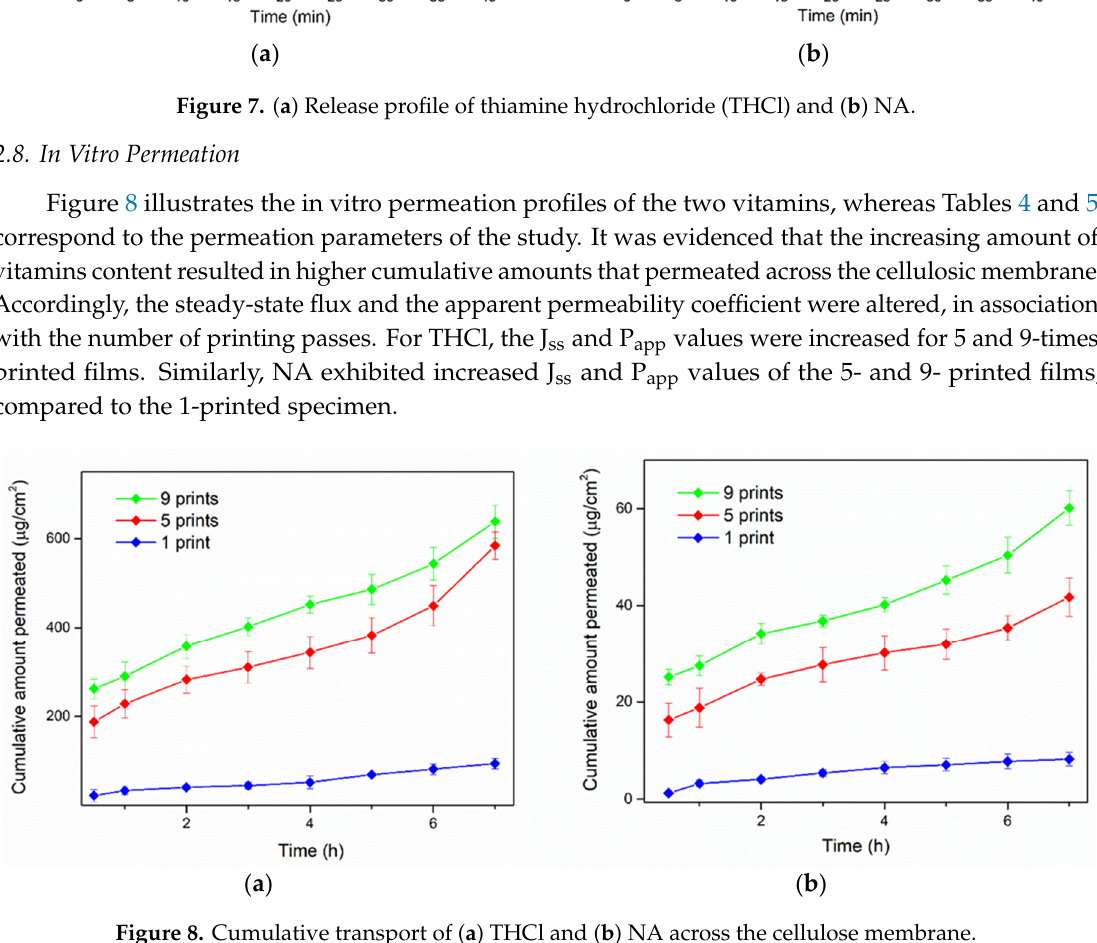
Figure 7. ( a ) Release profile of thiamine hydrochloride (THCl) and ( b ) NA.